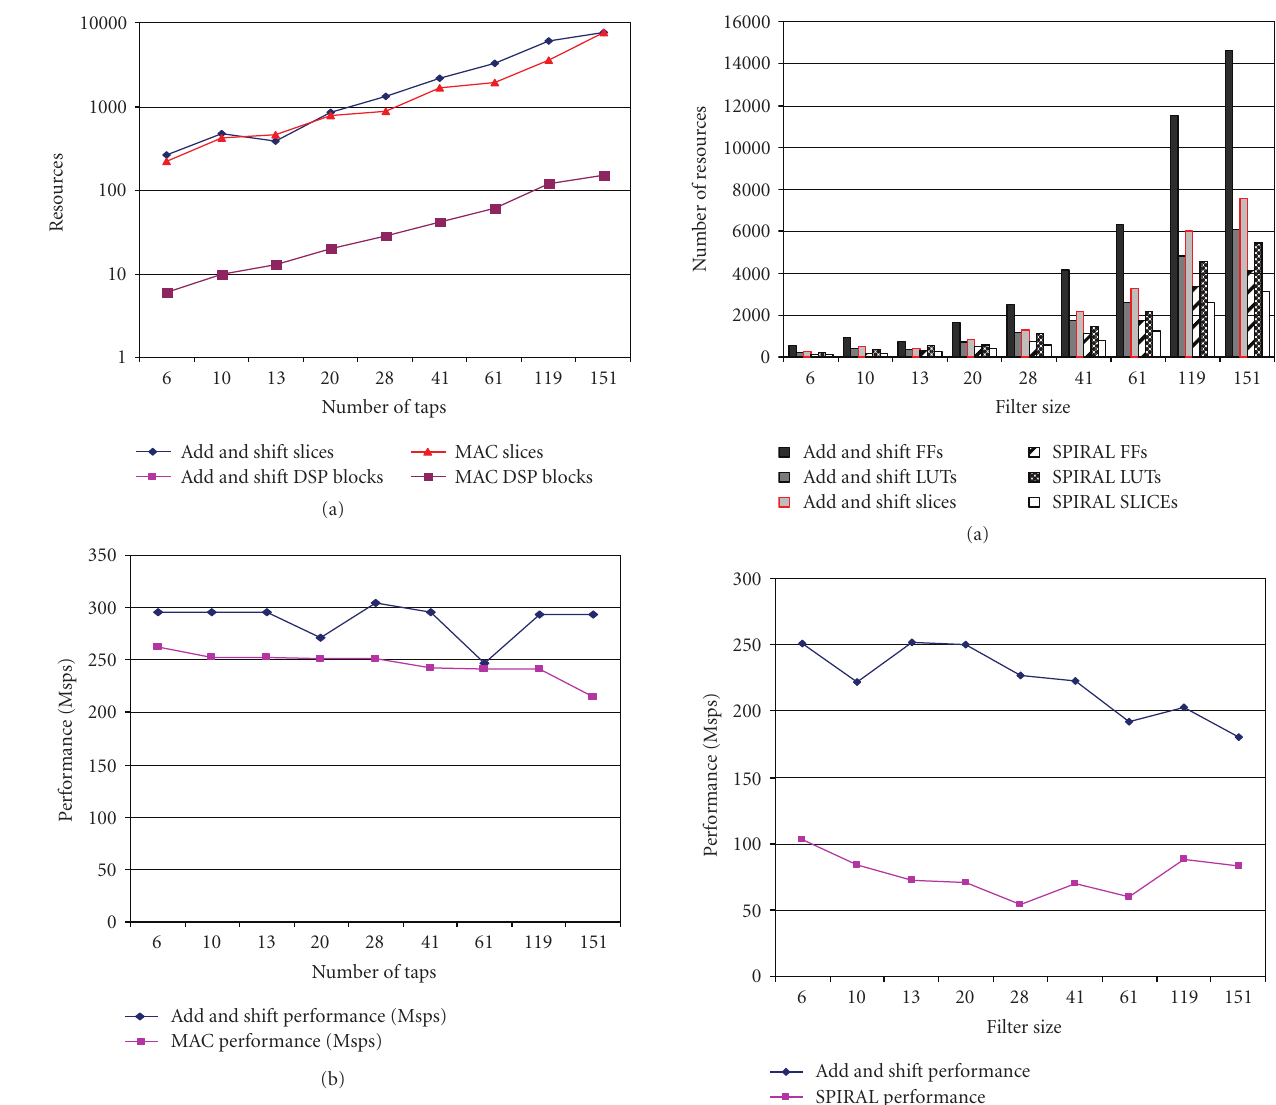
Figure 13: Resource utilization and performance implementation results for various filters using add and shift method (this paper) versus MAC method on Virtex IV. (a) Resource utilization in terms of no. of slices and DSP blocks presented in logarithmic scale. (b) Performance (Msps).